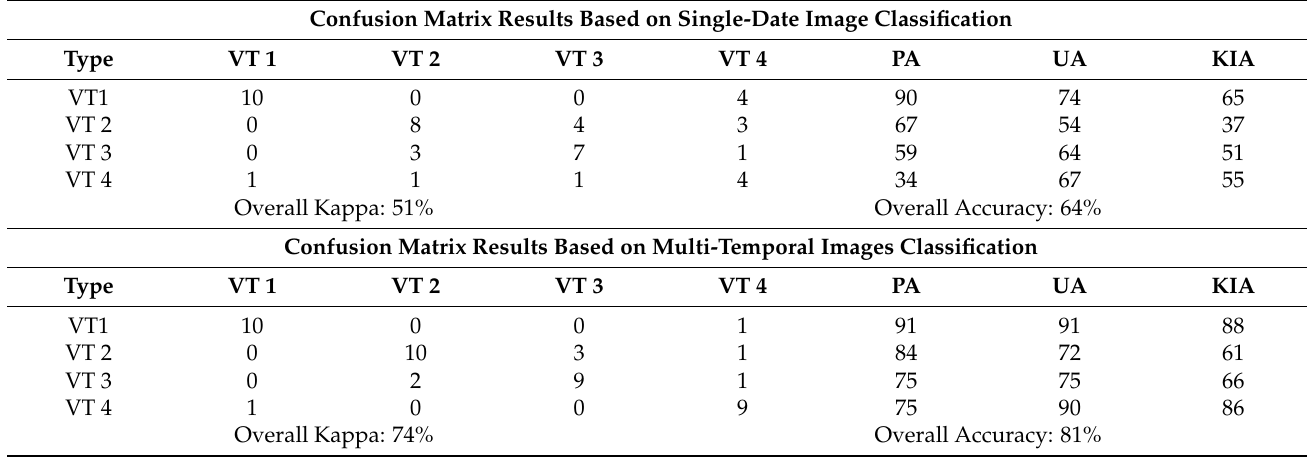
Table 3. Confusion matrix results. Summary of the classification accuracy for each VT by single-date images and multi- temporal images.